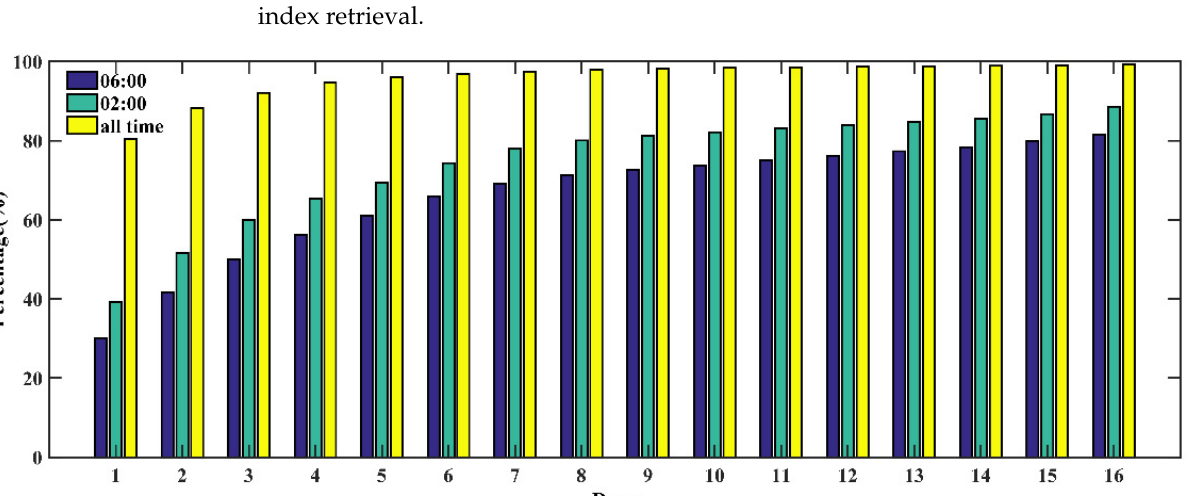
Figure 3. AHI observations over 16 days of compositing period. The color bars represent the percent of AHI clear pixels in our study domain, as defined in Figure 2.